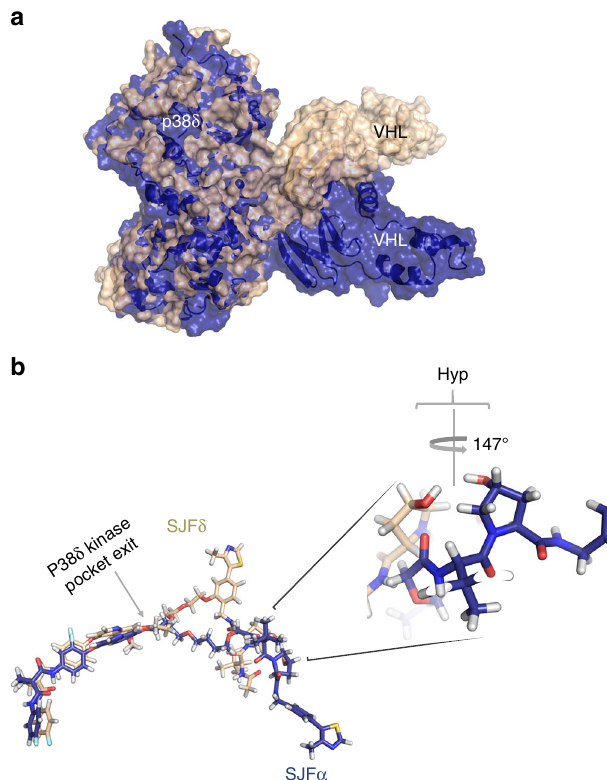
Fig. 5 MD simulations reveal PPI interfaces between p38 δ and VHL that vary between SJF δ and SJF α recruitment. a The SJF δ -recruited VHL interacts with p38 δ in a different mode than the SJF α -recruited VHL. p38 δ , VHL, and either SJF δ or SJF α were docked and a 100-ns MD simulation relaxed the ternary structure. The p38 δ :SJF δ :VHL ternary complex is colored in tan and the p38 δ :SJF α :VHL ternary complex is colored in dark blue. The p38 δ structures from both ternary complex MD simulations were aligned and the resulting divergent VHL structures can be visualized. b SJF δ and SJF α PROTACs deviate at the exit of the p38 δ kinase pocket to interact with the p38 δ :VHL PPI interface in distinct ways. Using the same p38 δ alignment as in ( a ), the p38 δ and VHL structures were hidden such that individual PROTACs could be visualized in stick representation. SJF δ carbons are colored in tan and SJF α carbons are colored in dark blue with oxygen atoms colored in red, nitrogen atoms in blue, sulfur atoms in yellow, and fl uorine atoms in pale blue for both PROTACs. SJF δ or SJF α (which are composed of the same foretinib warhead) show profound alignment within the p38 δ kinase, but deviate greatly upon exiting the pocket. Linker length differences between SJF δ (10 atoms) and SJF α (13-atoms) reveal the limits in their respective ability to dock along the p38 δ :VHL PPI interface. In addition, the orientation of attachment of the VHL-recruiting ligands result in hydroxyproline (Hyp) moieties that differ by ~147° between the